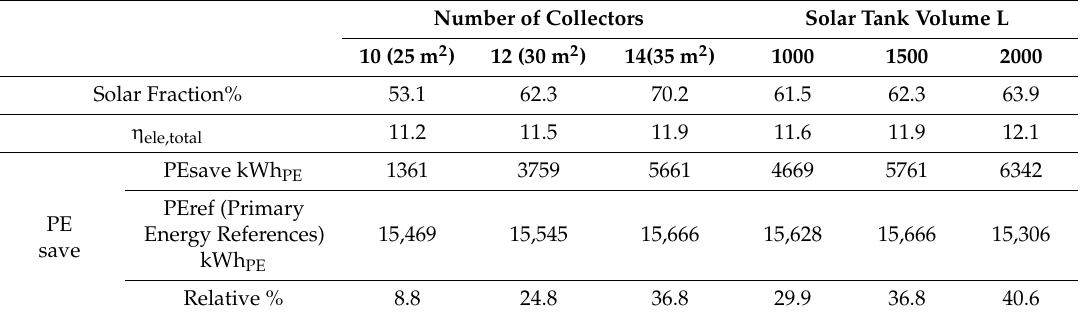
Table 6. Primary energy performance for various collector areas and solar tank